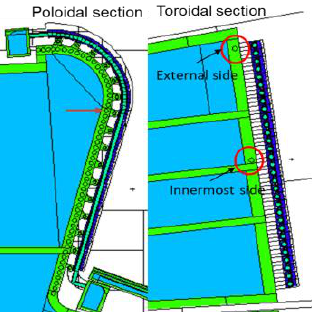
Figure 50. External and innermost CB layers on the inner target, subdivided into 56 spheres for the nuclear loads assessment.